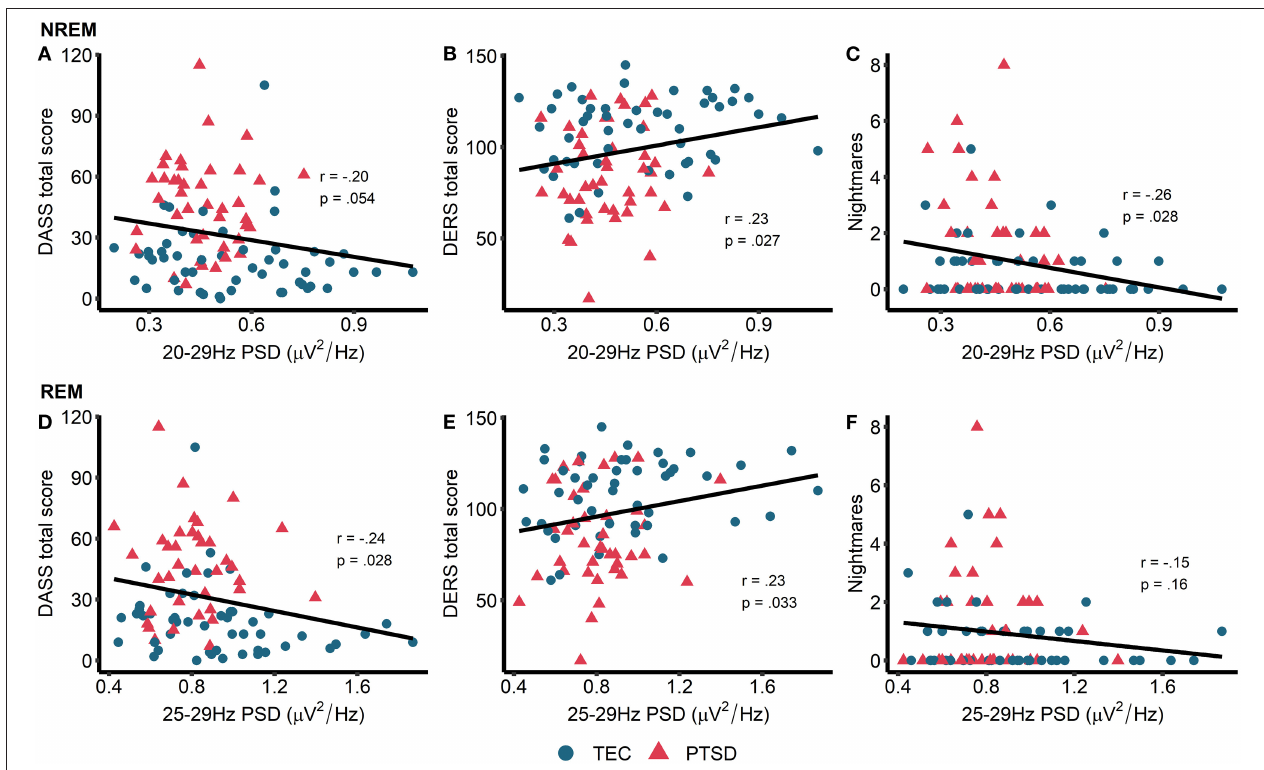
FIGURE 4 | Exploratory correlations. Top row: correlations between NREM high frequency power and general psychopathology (higher score = more symptoms of depression, anxiety, and stress) (A) , emotion regulation (higher score = better able to regulate emotions) (B) , and nightmare frequency (C) . Bottom row: correlations between REM high frequency power and general psychopathology (D) , emotion regulation (E) , and nightmare frequency (F) . Note that PSD at each frequency is relative to the average PSD in the 0–30 Hz range.